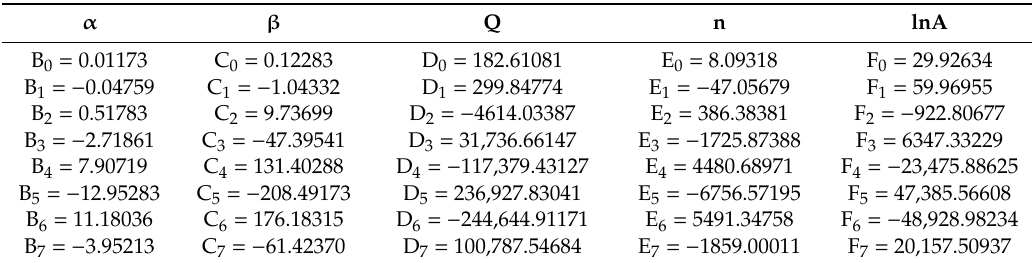
Table 2. Coe ffi cients of polynomial fit for α , β , Q , n , and ln A in Equation (8) for Al-Zn-Mg-Cu